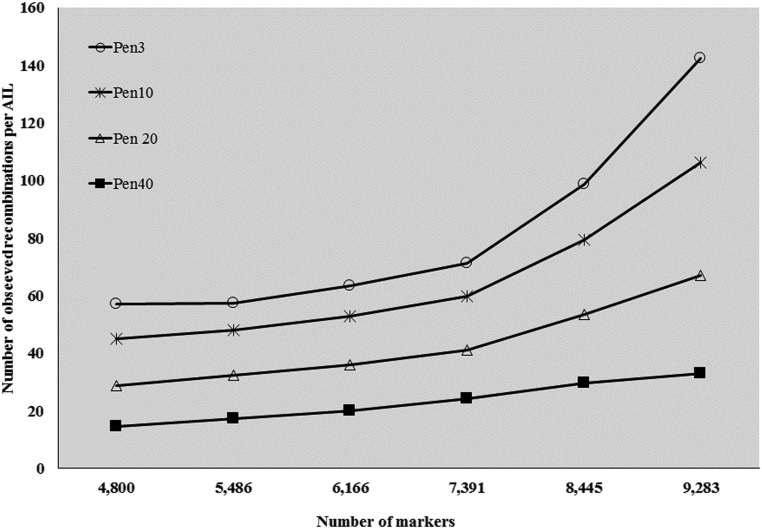
Graph showing the trend in average number of observed recombinations per line of indica MAGIC (MI) population. The estimates are made at varying numbers of markers (x-axis) and penalty (Pen) levels. The x-axis indicates the number of single nucleotide polymorphism (SNP) markers used for estimating recombinations/marker sets (see Figure 1). Recombinations were estimated at a genotyping error probability of 0.3. AIL, advanced intercross lines.